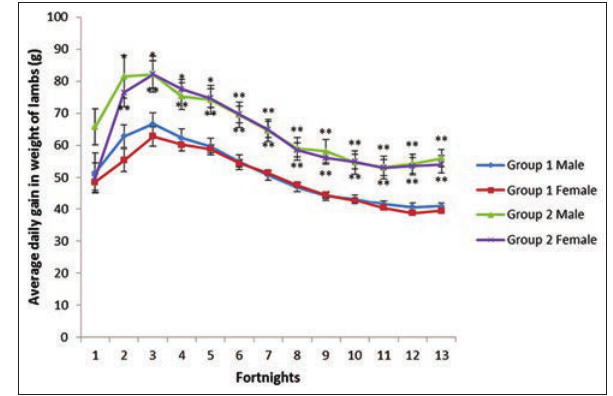
Figure-4: Mean±standard error values of fortnightly average daily gain in weight of lambs of different groups. *Significantly different from the base value (p<0.05). **Significantly different from the base value